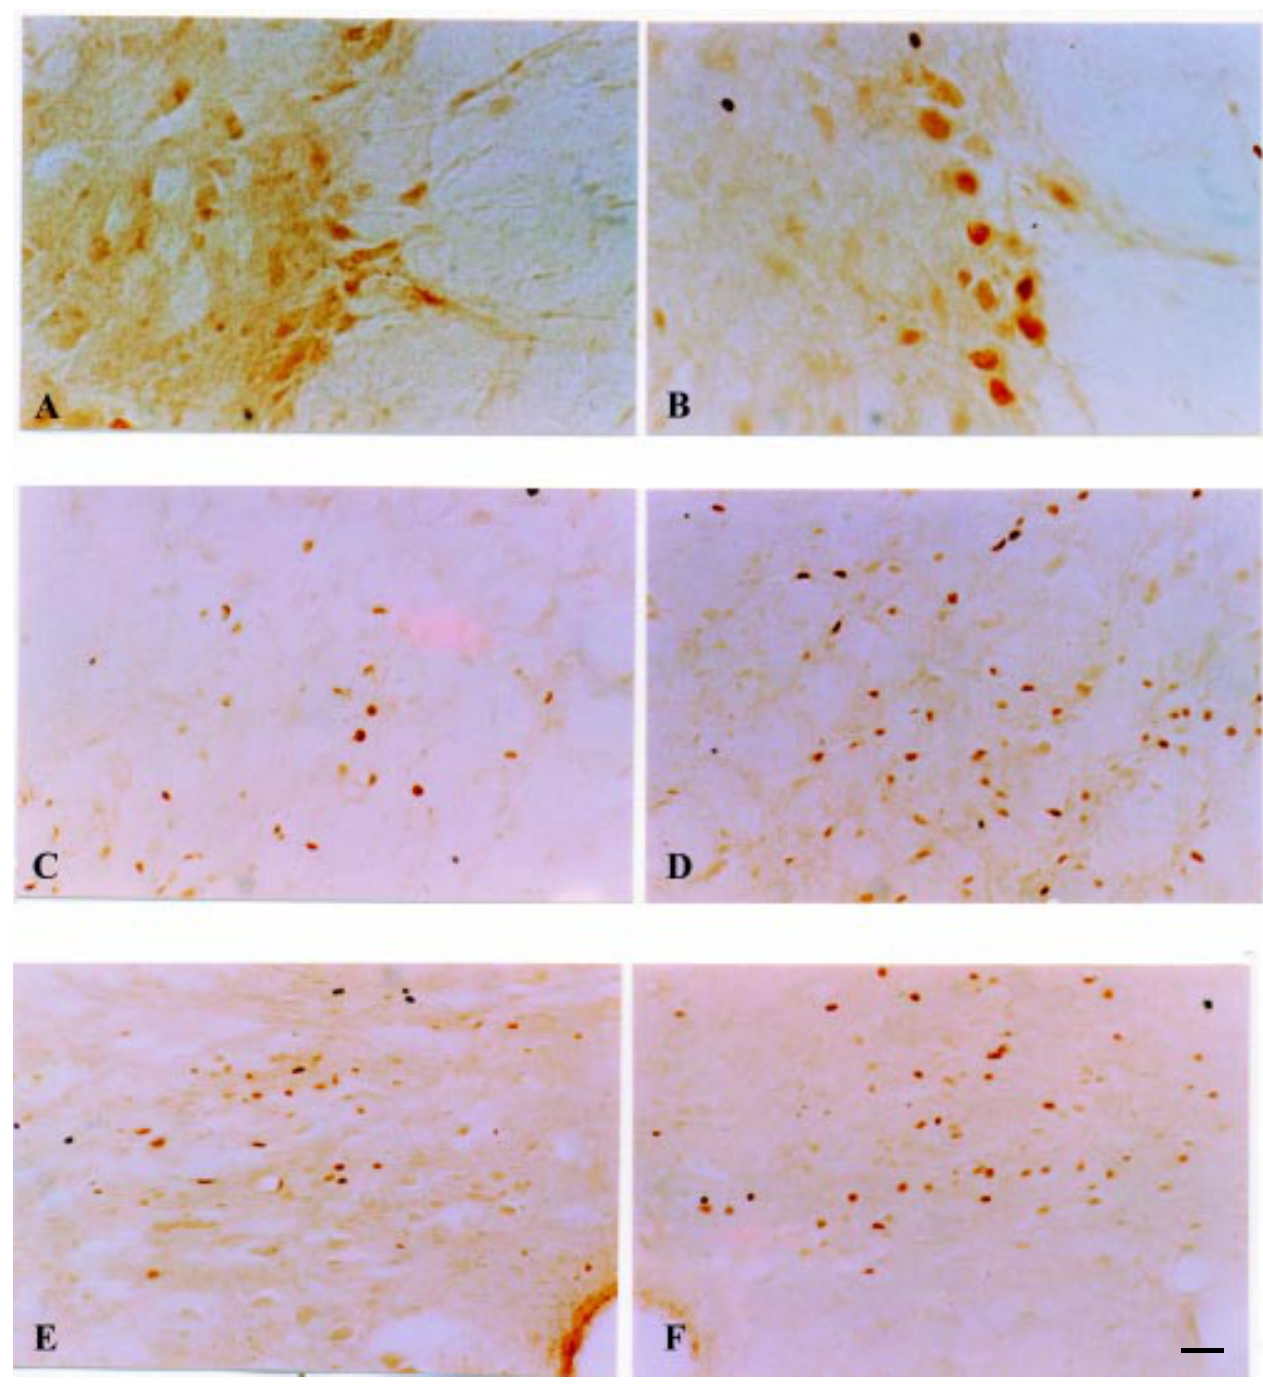
Figure 2 - Expression of Fos protein detected by immunocytochemistry in the thoracic segment of the spinal cord and in midbrain structures. A , Fos expression detected at the thoracic segment level in group 2 animals (laminectomy), in cells of the intermediolateral spinal cord nuclei. B , Fos expression detected at the thoracic segment level in group 3 animals (contusion), in cells of the intermediolateral spinal cord nuclei. C , Fos expression detected in nuclei of the reticular formation in group 2 animals (laminectomy). D , Fos expression detected in nuclei of the reticular formation in group 3 animals (contusion); E , Fos expression detected in the solitary tract nucleus at the midbrain level in group 2 animals (laminectomy). F , Fos expression detected in the solitary tract nucleus at the midbrain level in group 3 animals (contusion). Bar = 50